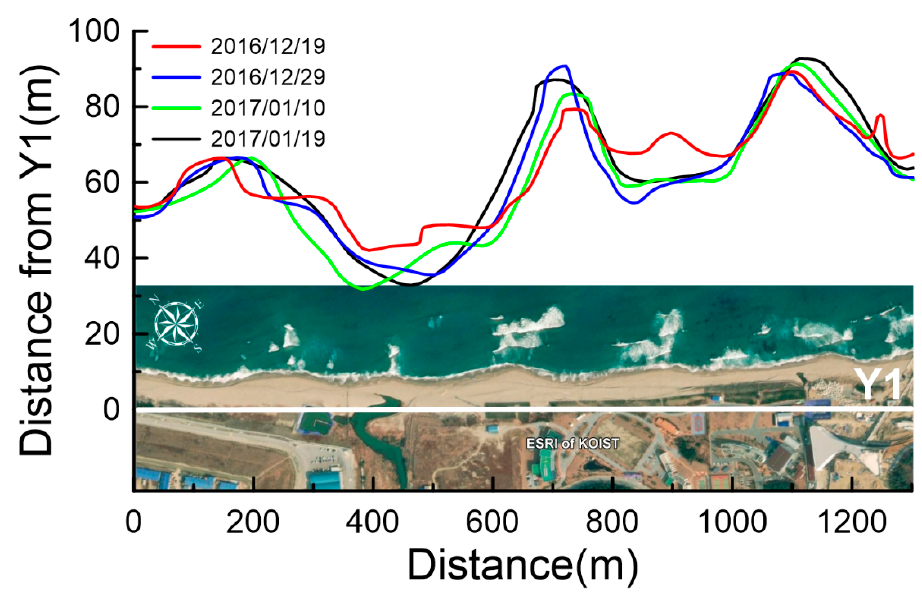
Figure 7. Comparison of shoreline positions in Hujeong Beach measured by VMS between 19 December 2016, 29 December 2016, 10 January 2017 and 19 January 2017 for Exp#1. The google map shows the corresponding locations of the retreat/accretion areas along the beach.